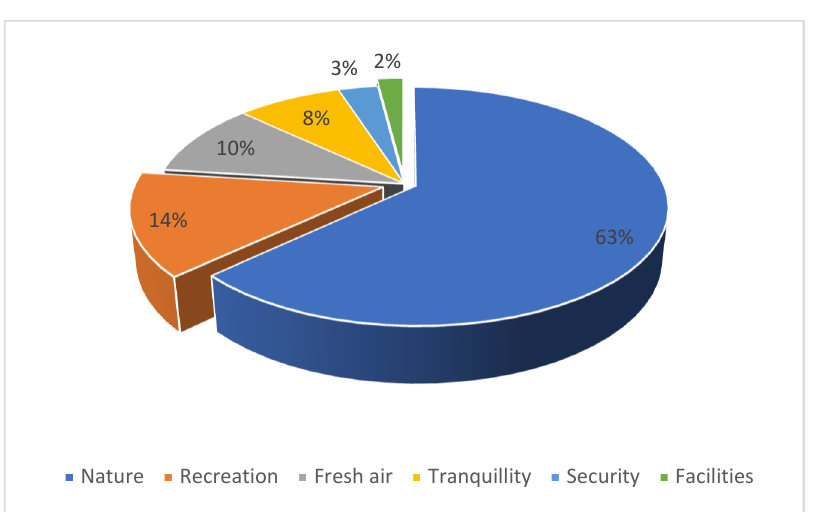
Figure 3. Main motivations of the interviewees to visit the Mirador Sur Park according to the visitation period.